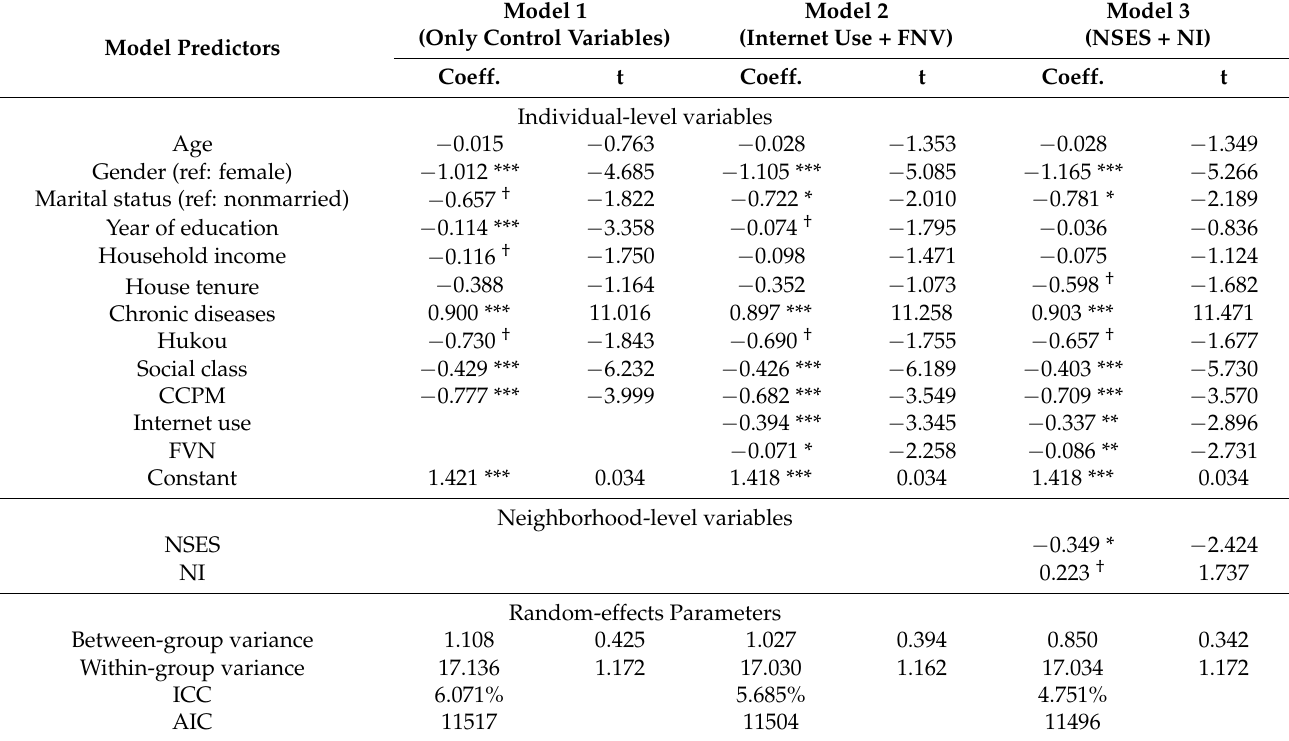
Table 2. Multilevel models on mental distress, Internet use, and neighborhood